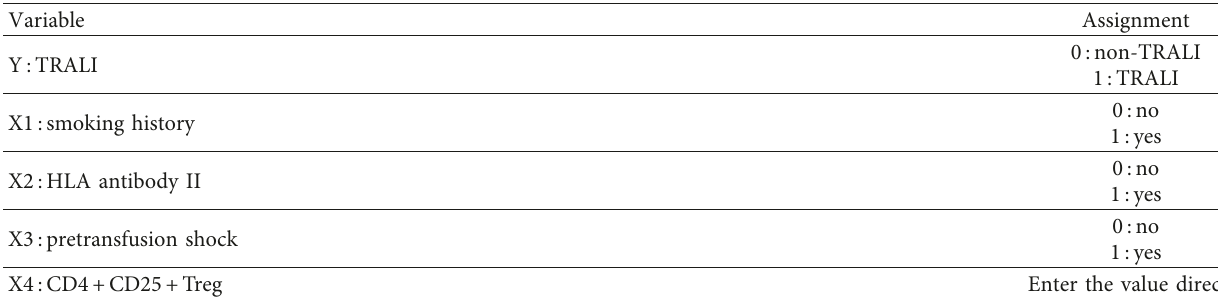
Table 2: Variable assignment.